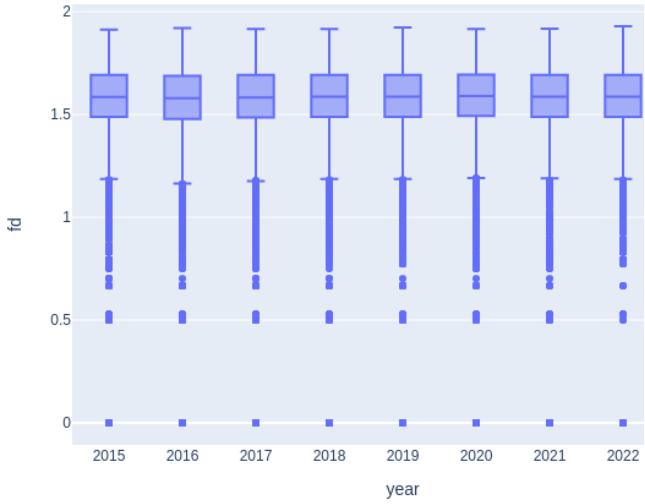
Figure 8. Box plot of the fractal dimension (fd) for the time period 2015–2022; the studied region is in Yamal.